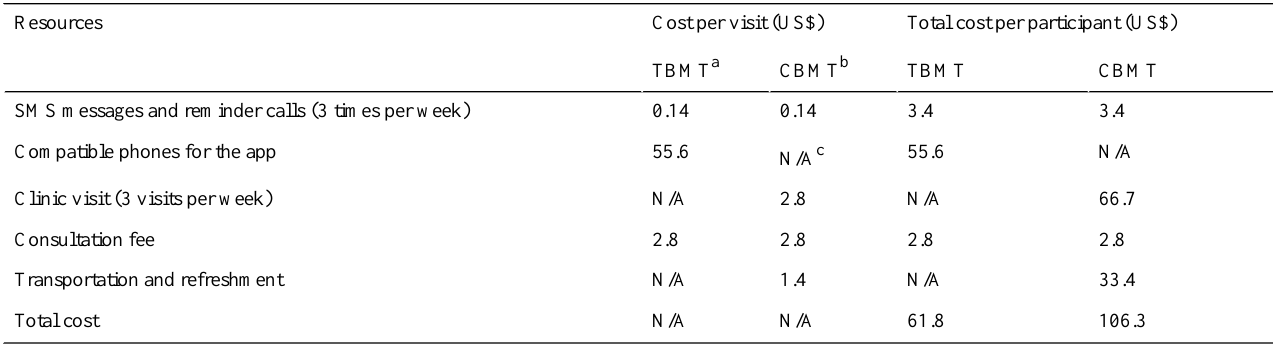
Table 2. Cost associated with implementation of telerehabilitation-based McKenzie therapy and clinic-based McKenzie therapy.